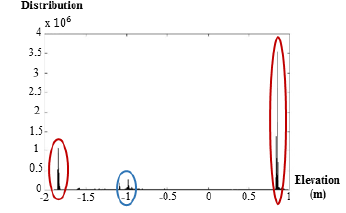
Figure 7. Histogram of elevation of the actual point